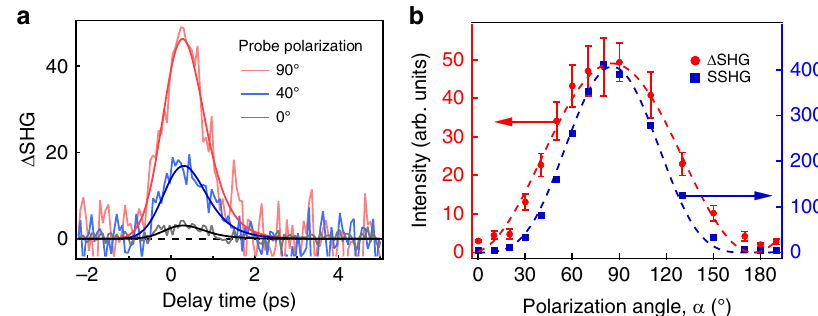
Fig. 3 Probe polarization dependence of the second harmonic signal. a Pump-induced ME-FISH ( Δ SHG) signals from the pentacene thin fi lm for three different probe polarization angles. At 0 o polarization, the E fi eld is vertical, parallel to the sample surface. At 90 o polarization, the E fi eld is horizontal, parallel to the propagation axis of the pump. b Polarization angle dependence for surface SHG (squares) and pump-induced SHG (circles). The dashed curves are the fi ts with sin 4 ( α ) and sin 2 ( α ) functions for SSHG and Δ SHG, respectively. The error bars were determined by the variance of the signal before time